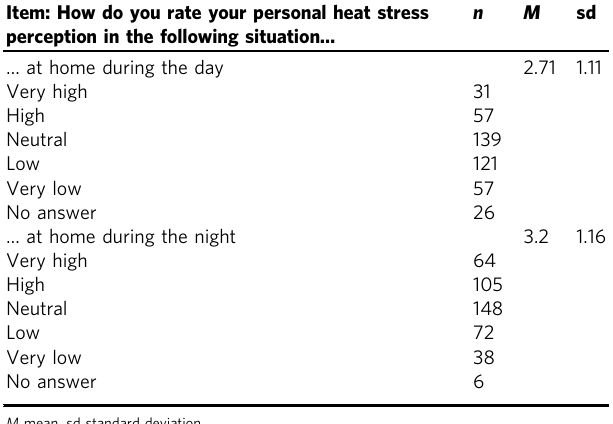
Table 7 Subjective heat stress item and statistics. Item: How do you rate your personal heat stress perception in the following situation …